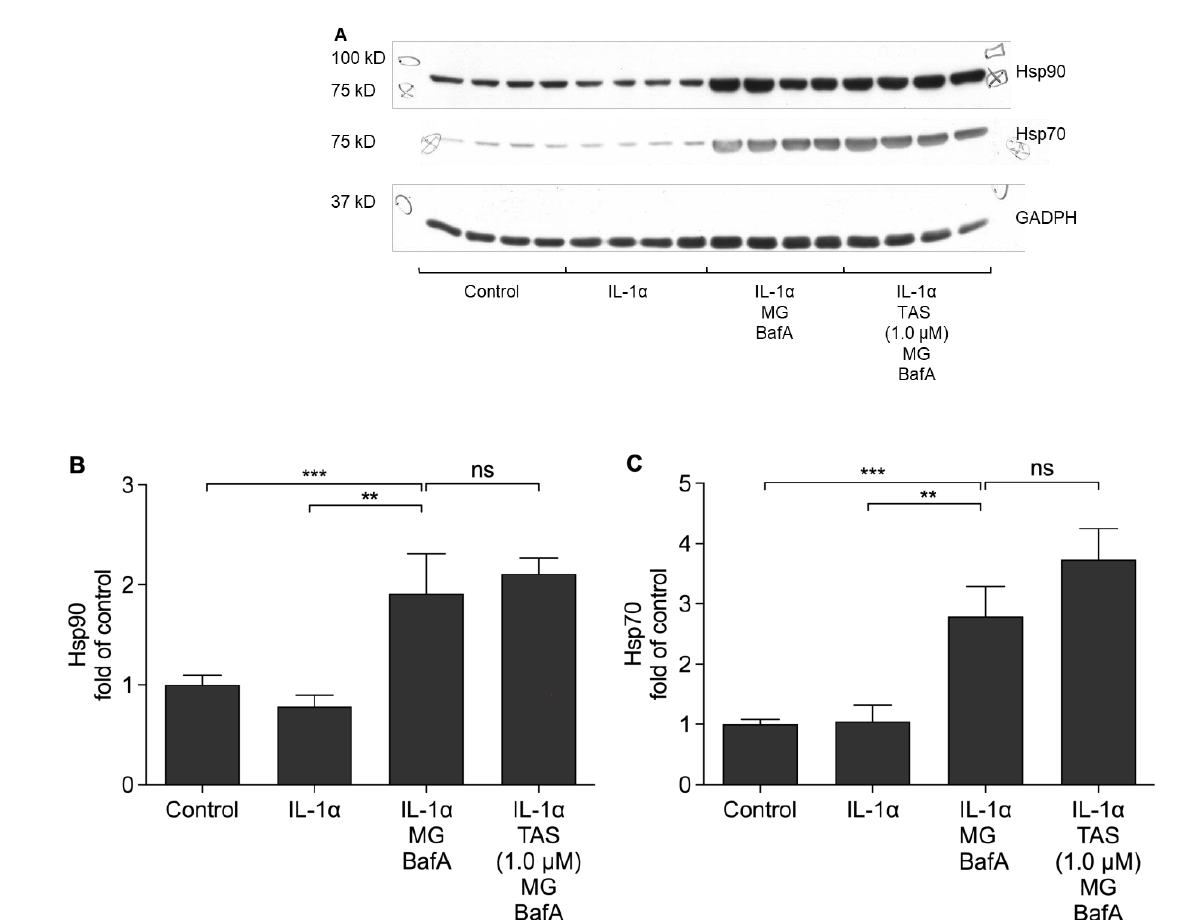
Figure 6. Representative images of protein levels of Hsp90 and Hsp70 in cell lysates determined using the Western blot technique ( A ). Quantified protein levels of Hsp90 ( B ) and Hsp70 ( C ). IL-1α-primed RPE cells treated with MG-132 (MG) + Bafilomycin A1 (BafA) and TAS-116 (TAS) if indicated. Data are combined from two independent experiments with four parallel samples in each group per experiment. Results are presented as mean ± SEM. ** p < 0.01, *** p < 0.001, ns = nonsignificant, Mann–Whitney U test.